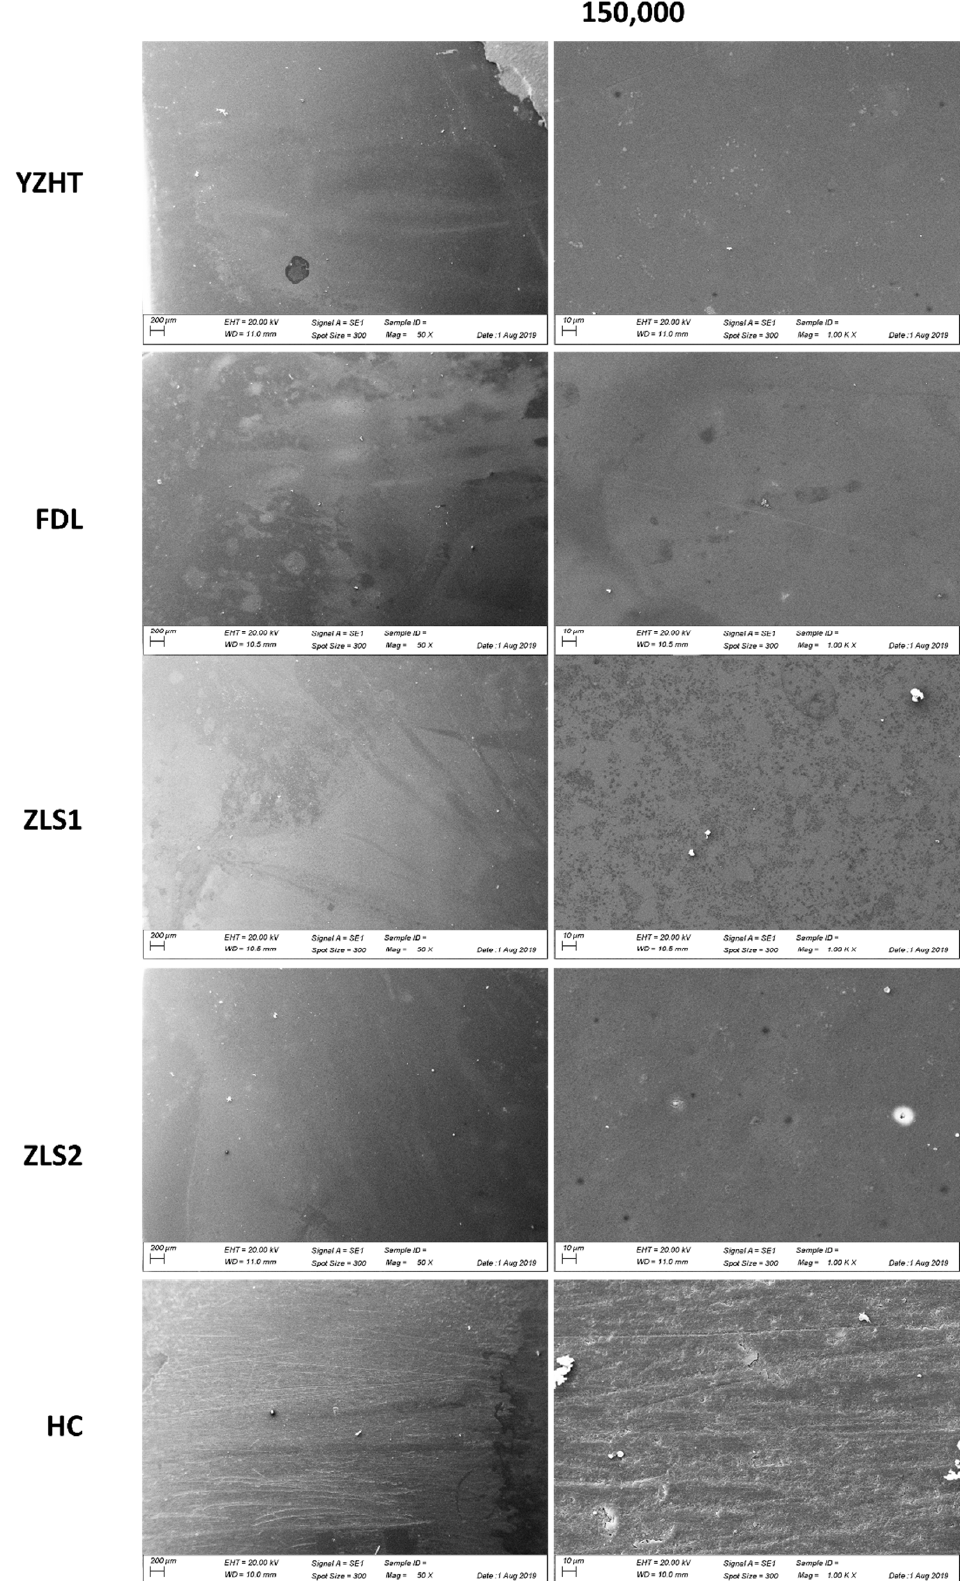
Figure 5. Scanning electron microscopy of surface topography with 50× and 1000× magnification according to the ceramic material (YZHT, FDL, ZLS1, ZLS2 and HC) for 15 years of evaluation.